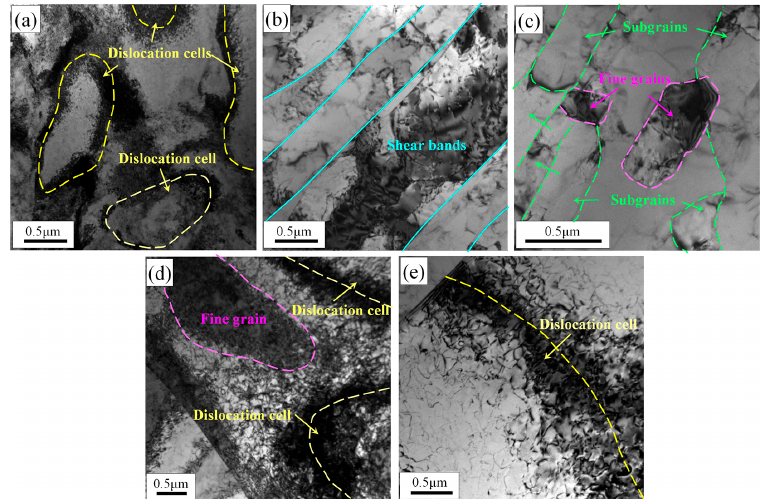
Figure 6. Geometrically necessary dislocation (GND) distributions in the NiTiFe SMA subjected to ECAE at various temperatures: ( a ) 400 °C; ( b ) 450 °C; ( c ) 500 °C.